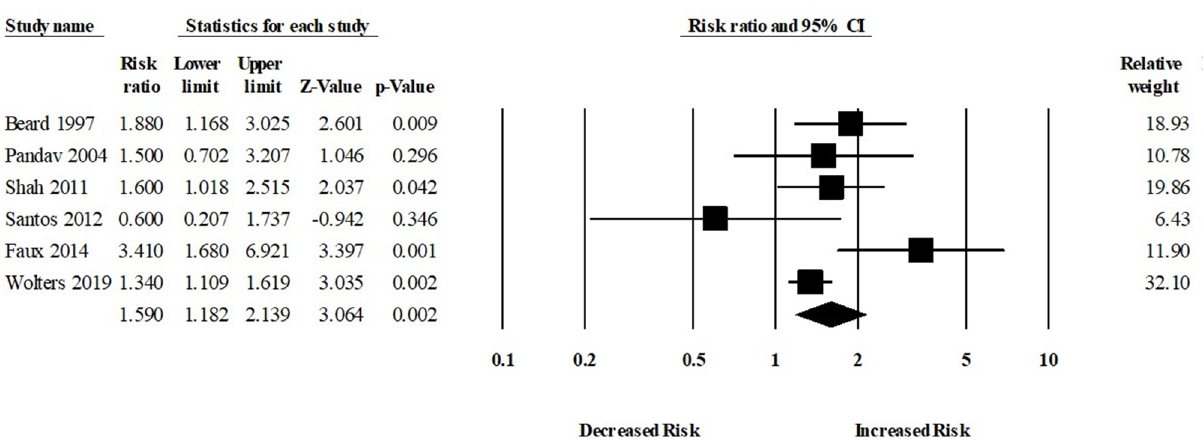
Figure 4. Association between anemia and Alzheimer’s disease [18,19,23,24,27,34].